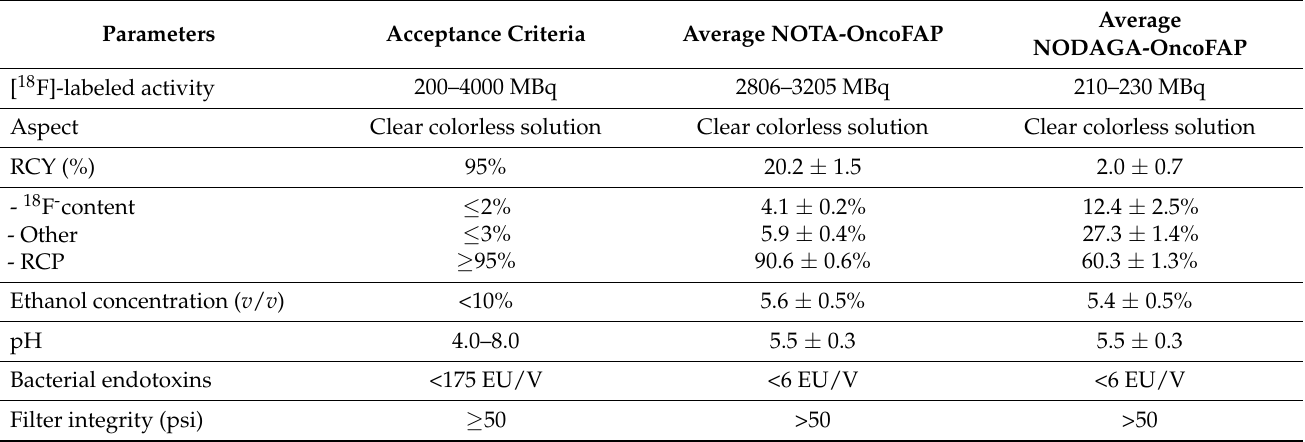
Table 9. Acceptance criteria and average result of five [ 18 F]AlF-OncoFAP synthesis obtained with condition of batch